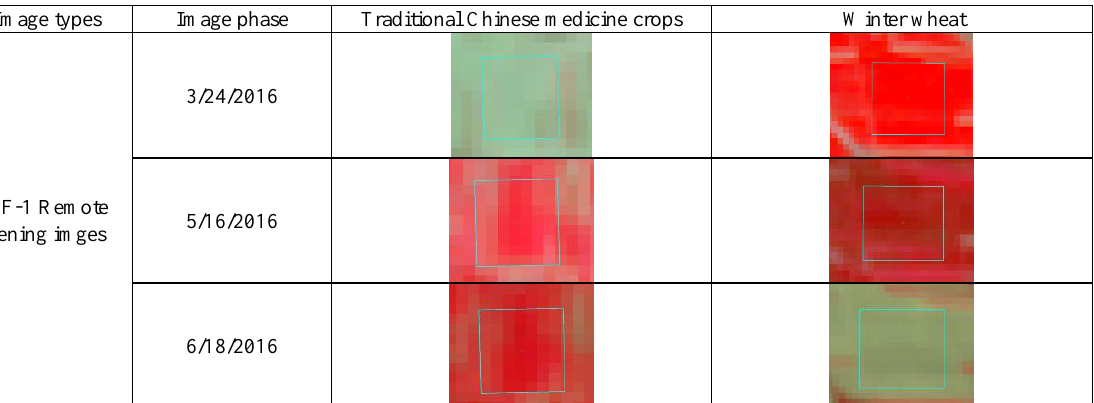
Table3. Different interpretation signs of traditional Chinese medicine crops and winter wheat in three critical growing periods In the image on March 24, 2016, Chinese medicine crops still exhibited near-naked information, while the winter wheat was in a period of vigorous growth and showed bright red in false color images. In the image on May 16, 2016, Chinese medicine crops were in a more vigorous growth period, presenting light red in the false color image and winter wheat showed dark